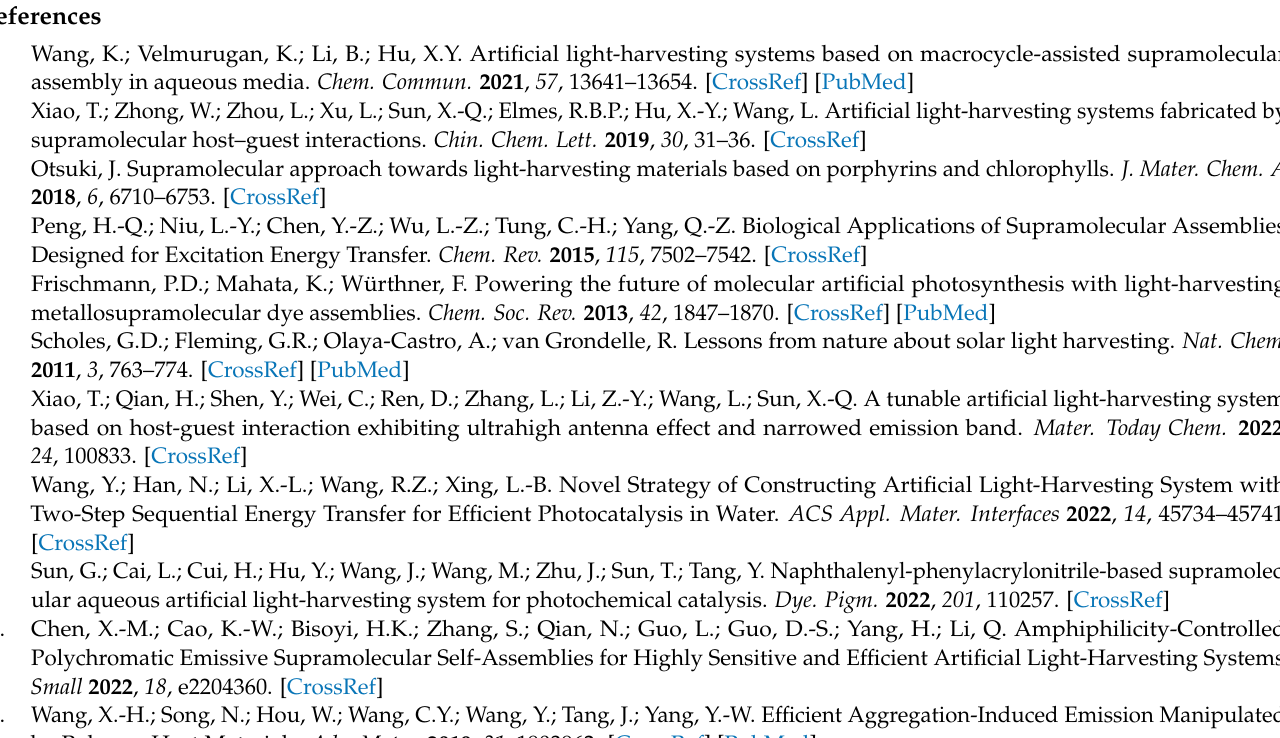
respectively. Table S3: Energy-transfer efficiency with different M / DBT ratio. Table S4: Antenna effect with different M / DBT ratio.; Scheme S1: Synthesis of M . Scheme S2: Chemical structure of TPE . References [47–50] are cited in the supplementary